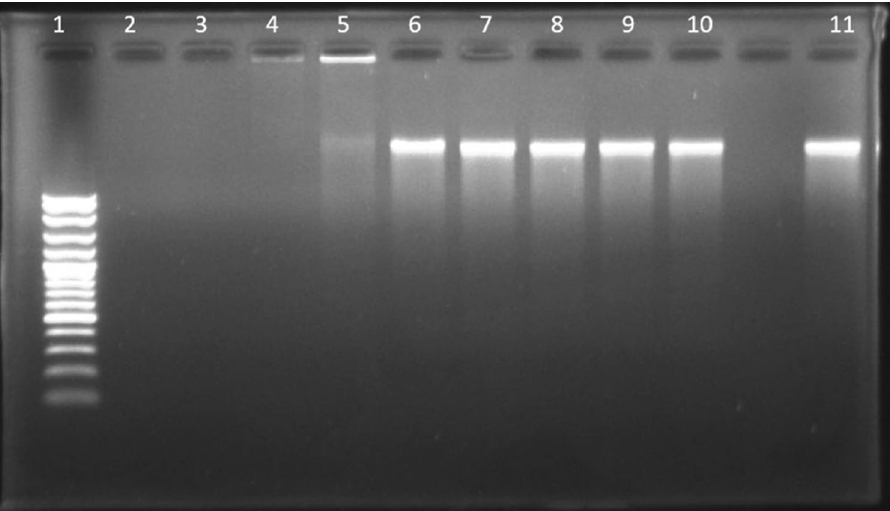
Figure 9. Gel retardation experiment used to measure the binding ability of A11 with genomic DNA of S . Typhimurium ATCC 13311. Lane 1: DNA Marker, lane 2: 250 μg/ml A11, lane 3: 125 μg/ml A11, lane 4: 62.5 μg/